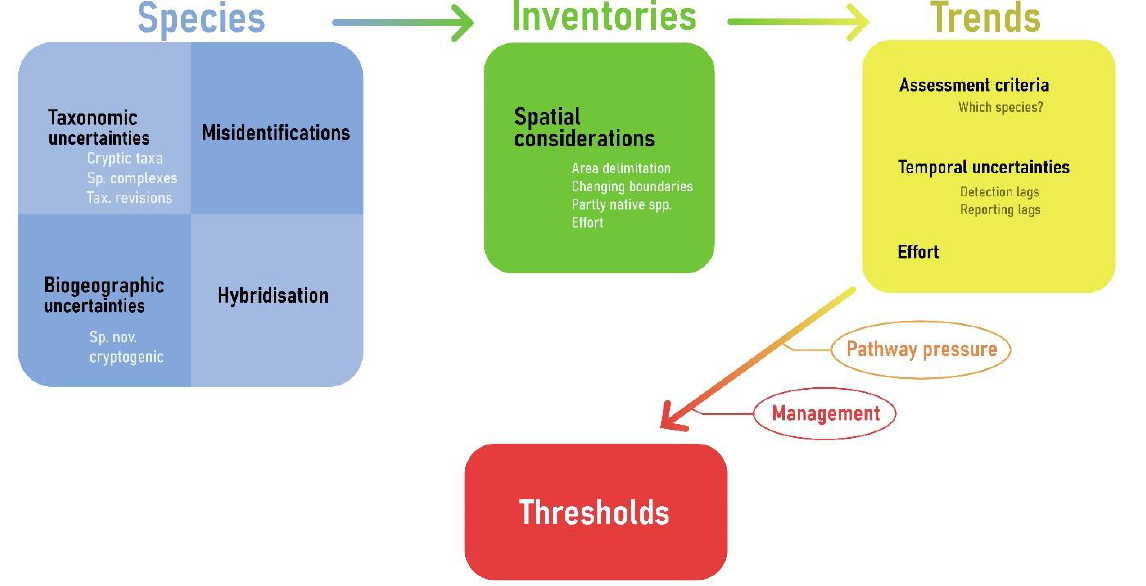
Figure 5. Schematic diagram of the process of NIS trends calculation identifying sources of tainty (outlined in rectangles) as they propagate from species to inventories to trends. Additional considerations for threshold setting are indicated by oval outlines. Sp. complexes = species complexes, Tax. Revisions = taxonomic revisions. Sp.nov. = species